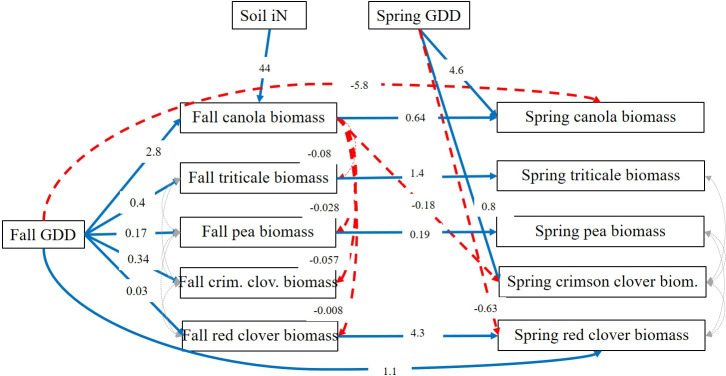
Structural equation model results.Significant unstandardized path coefficients from the Structural Equation Model (P<0.05). Blue solid arrows indicate a positive coefficient, red dashed arrows signify negative coefficients. Grey dotted arrows represent error covariance.